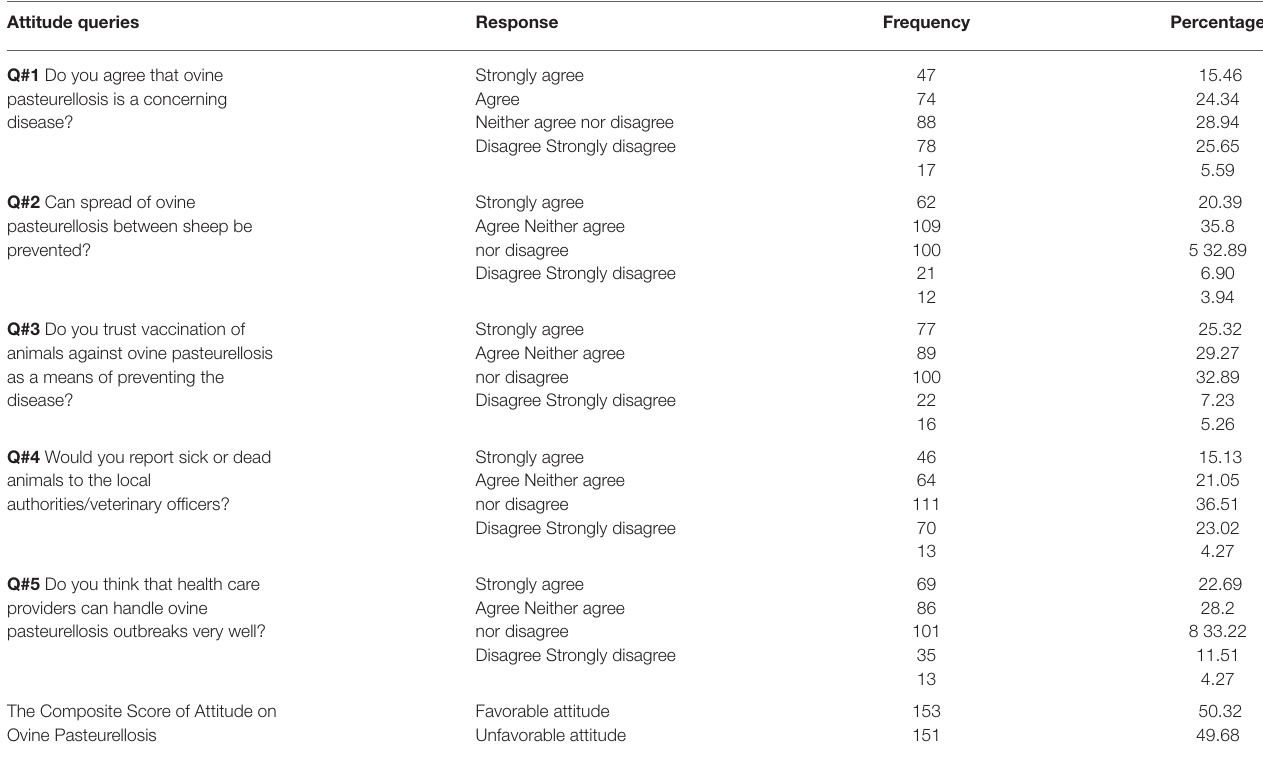
TABLE 2 | Respondents’ attitude toward ovine pasteurellosis ( n =